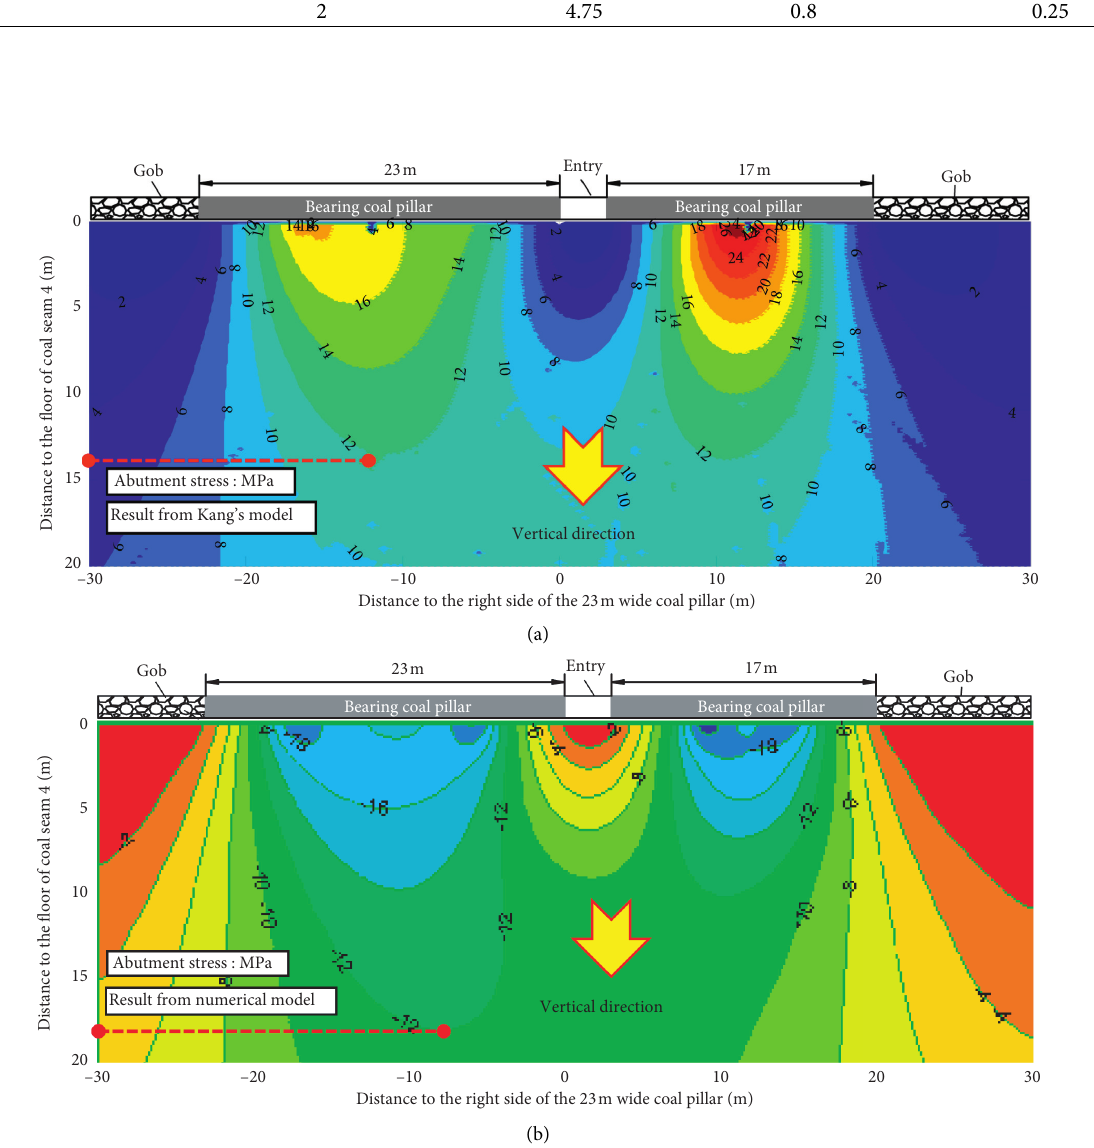
Figure 2: Distribution of the abutment stress under bearing coal pillars. (a) Theoretical calculation result; (b) numerical simulation